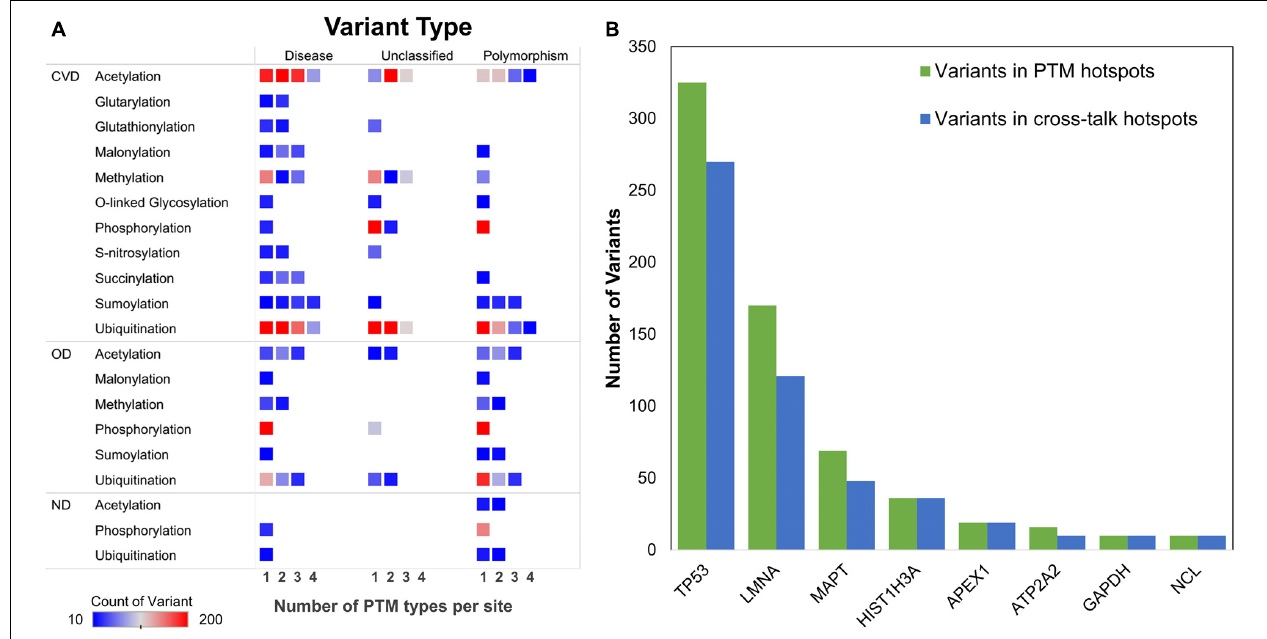
FIGURE 8 | (A) Distribution of MAVs in disease-associated proteins with respect to the number of PTM types per site. (B) Proteins with ≥ 10 MAVs in PTM and crosstalk hotspot